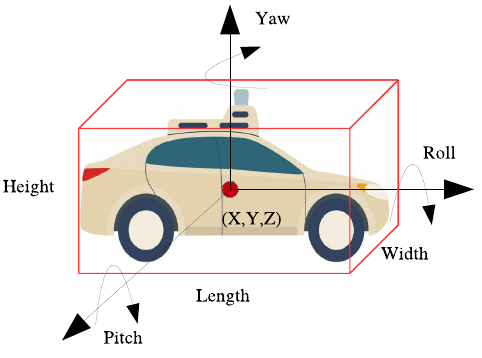
Figure 7. Degree-of-freedom for 3D object detection. A full-scale 3D bounding box contains nine DoF, while 3D detection in self-driving eliminates the roll and pitch